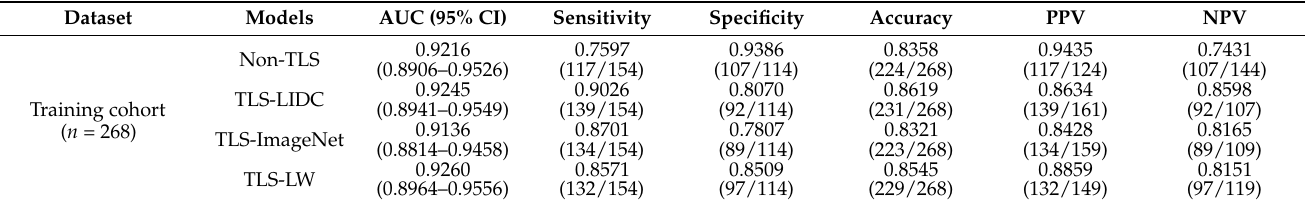
Table 3. Performance of transfer learning models based on different transfer sources (Non-TLS, TLS-LIDC, TLS-ImageNet, and TLS-LW) for the LAC and LGN groups among patients with SPSNs in the training cohort, four validation cohorts and whole validation